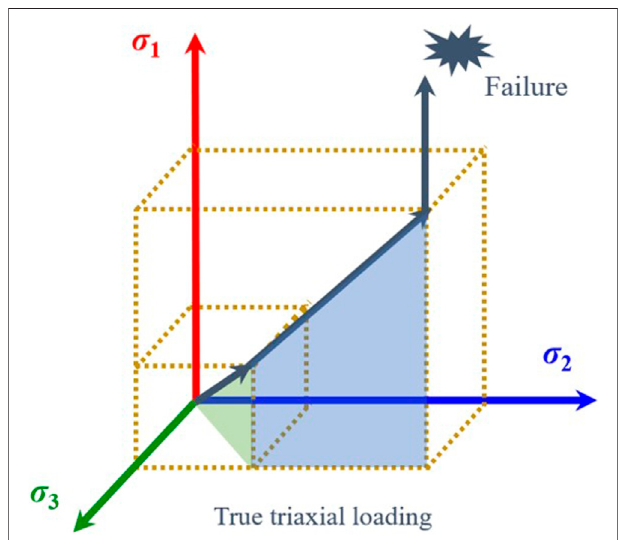
FIGURE 3 | Adopted true triaxial loading stress paths of tested